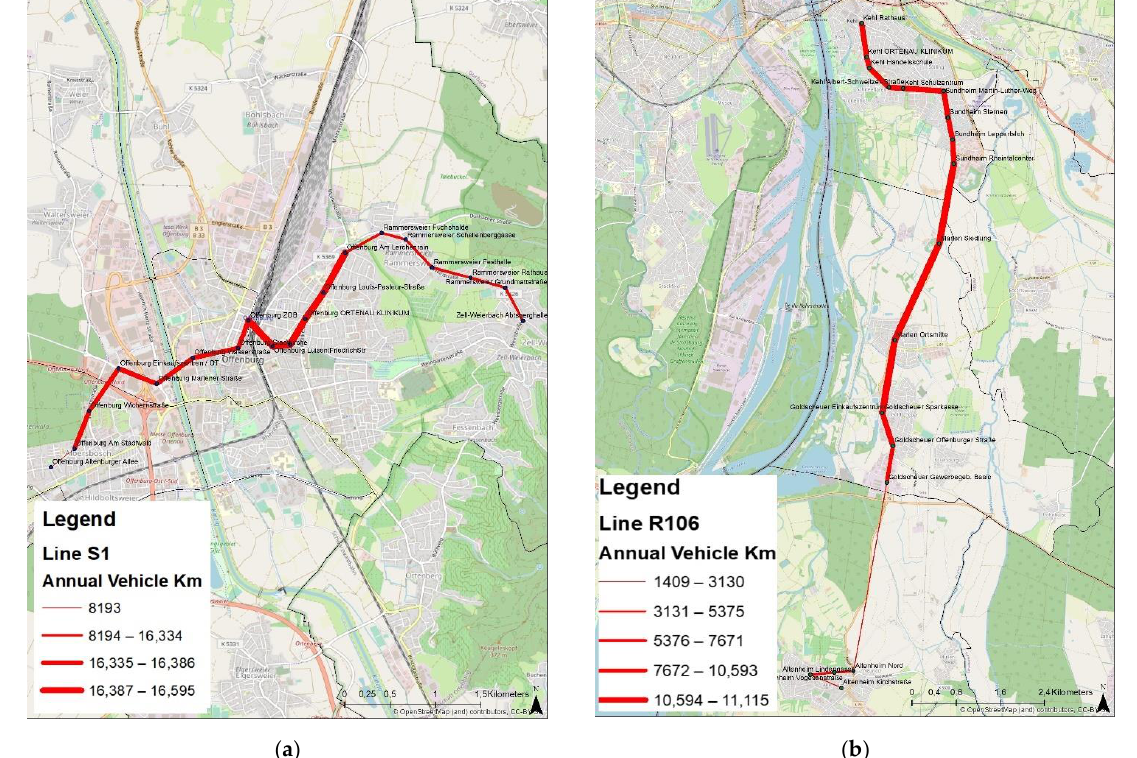
Figure 3. Structure analysis for bus lines in Offenburg: ( a ) city bus line S1; ( b ) regional line R106.